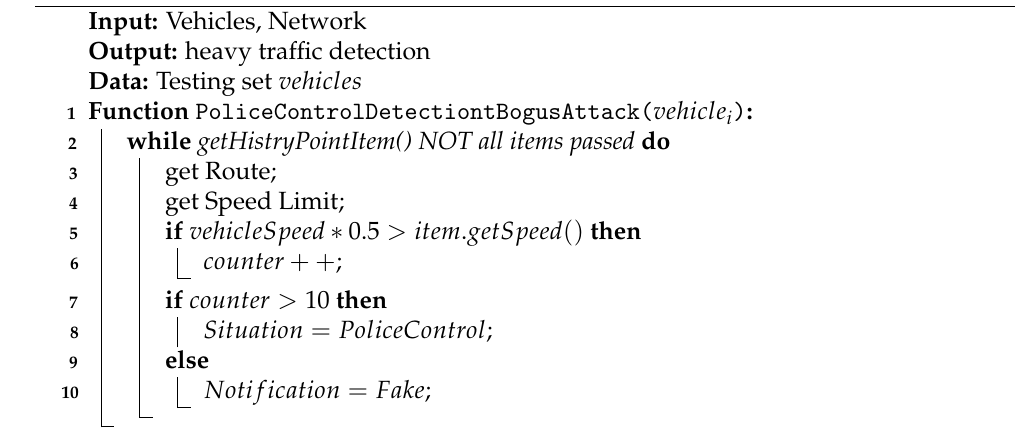
Algorithm 4: Handling police control detection during a bogus attack.